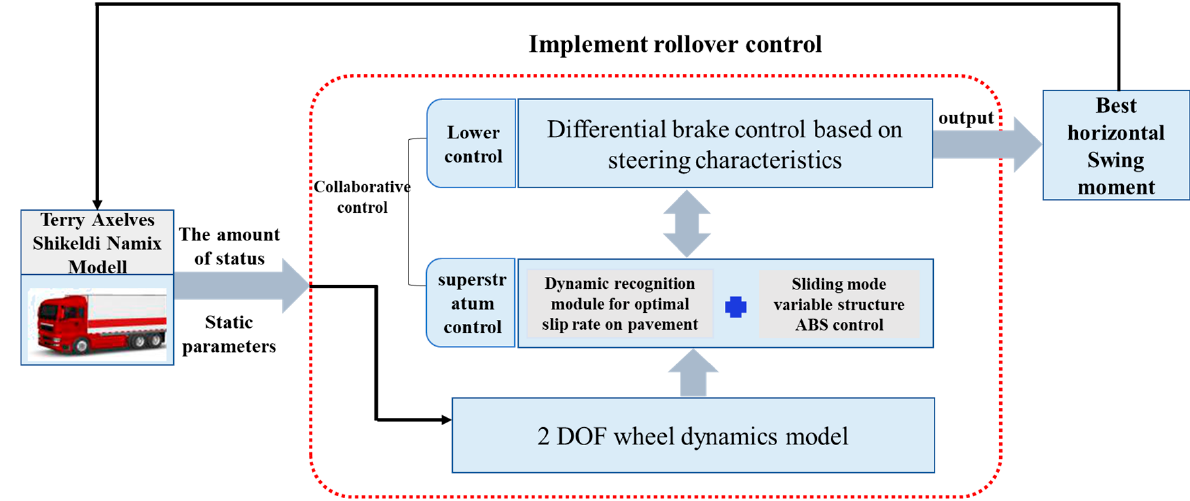
Figure 5. Anti-rollover control strategy based on the NLTR index.